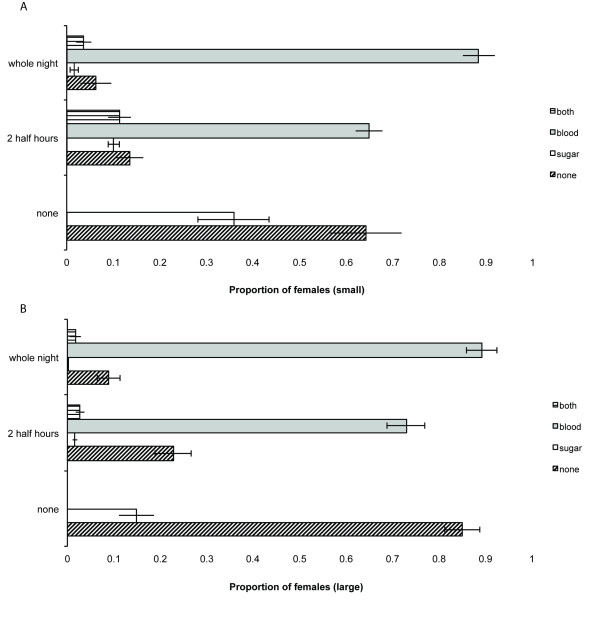
a,b: The proportions of small (a) and large (b) females ± SEM that fed on blood, sugar, both, or neither, when a blood host was accessible for 8 h, or for 2.5 h, or was not present. Both plant densities and all replicates are combined.